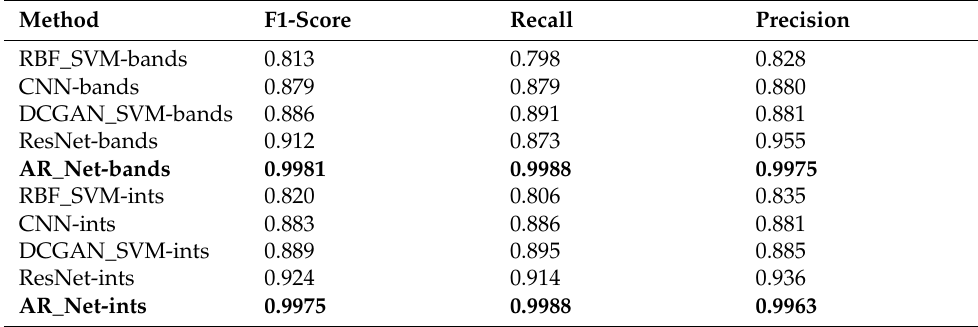
Table 3. Evaluations of different models on the PMPS-26k